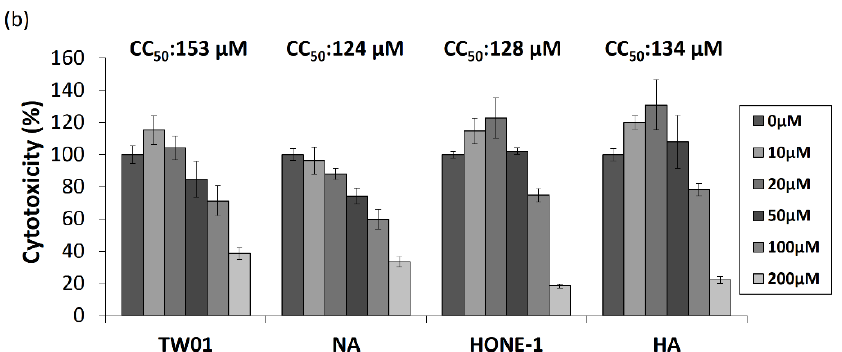
Figure 1. The chemical structure of kaempferol and its cytotoxicity to NPC cell lines. ( a ) The chemical structure of kaempferol. ( b ) Two sets of EBV-positive NPC cell lines and their parental counterparts (TW01/NA and HONE1/HA) are treated with various concentrations of kaempferol for 48 h. The cell viability was detected and CC 50 values were calculated (top of each panel). The values of each sample were derived from three independent trials.